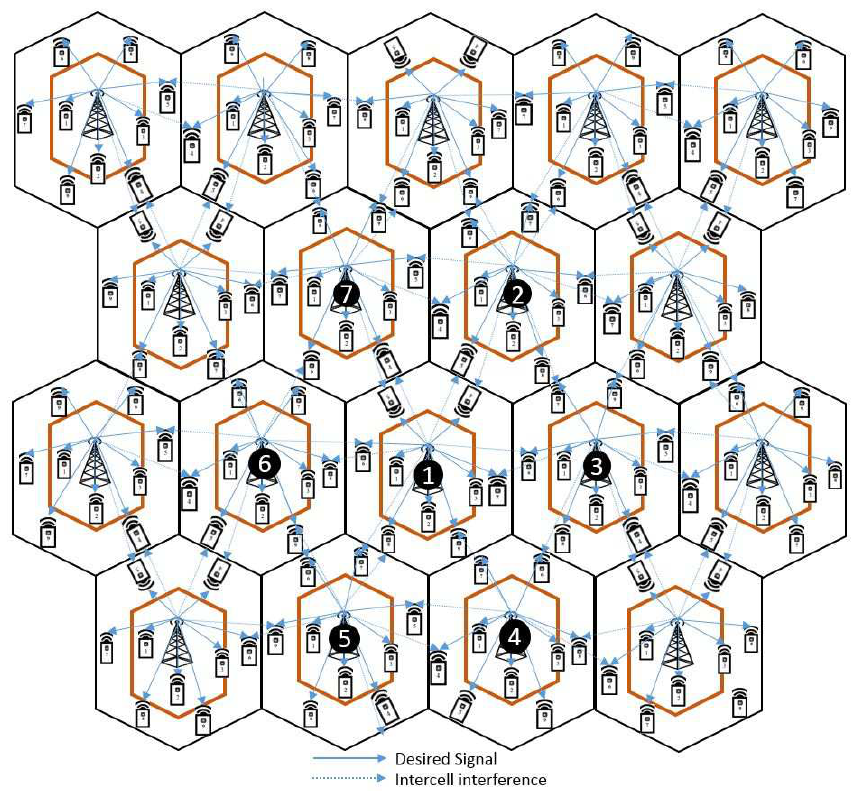
Figure 6. K -user MIMO Gaussian interference channel ( K = k and L = l